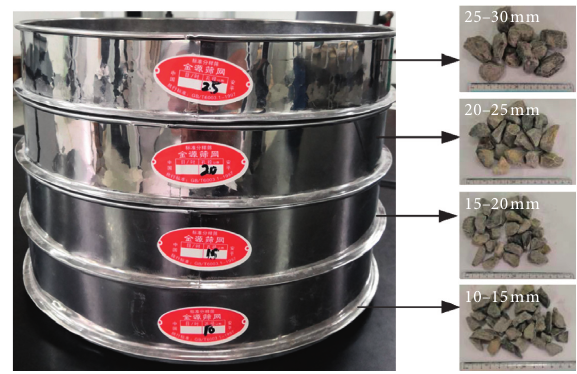
Figure 2: The screen and rock particles.